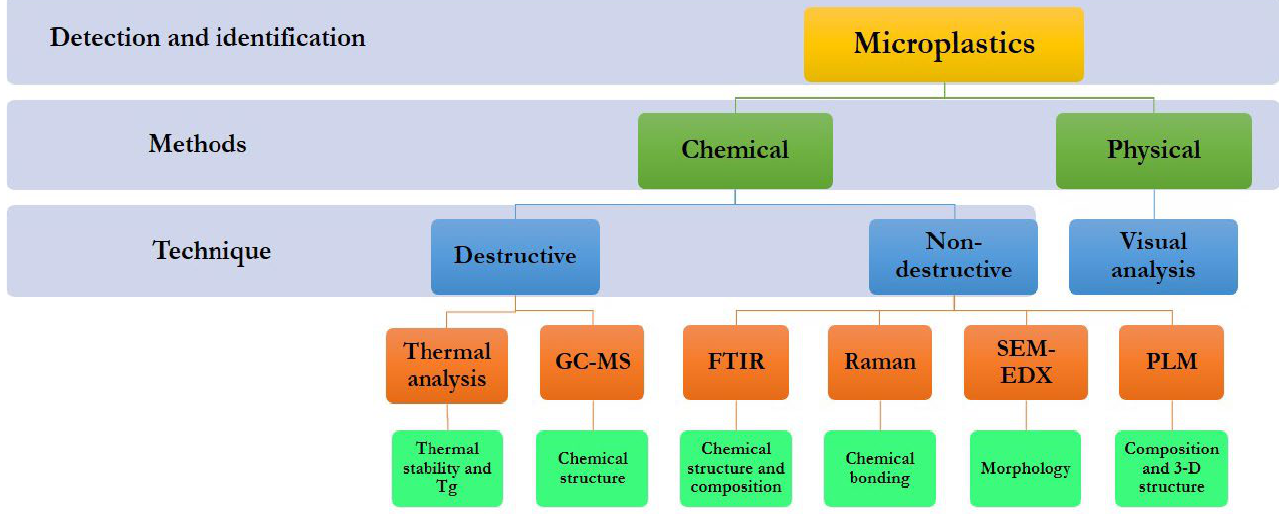
Figure 4. Methods for detection and identification of microplastics in aquatic systems .